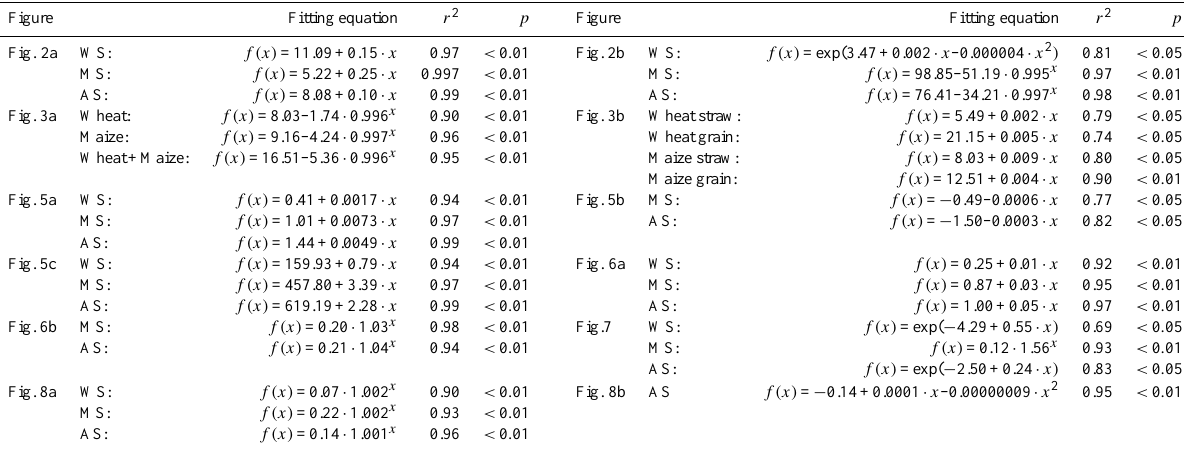
Table 3. Fitting equations for Figs. 2, 3, 5, 6, 7 and 8.